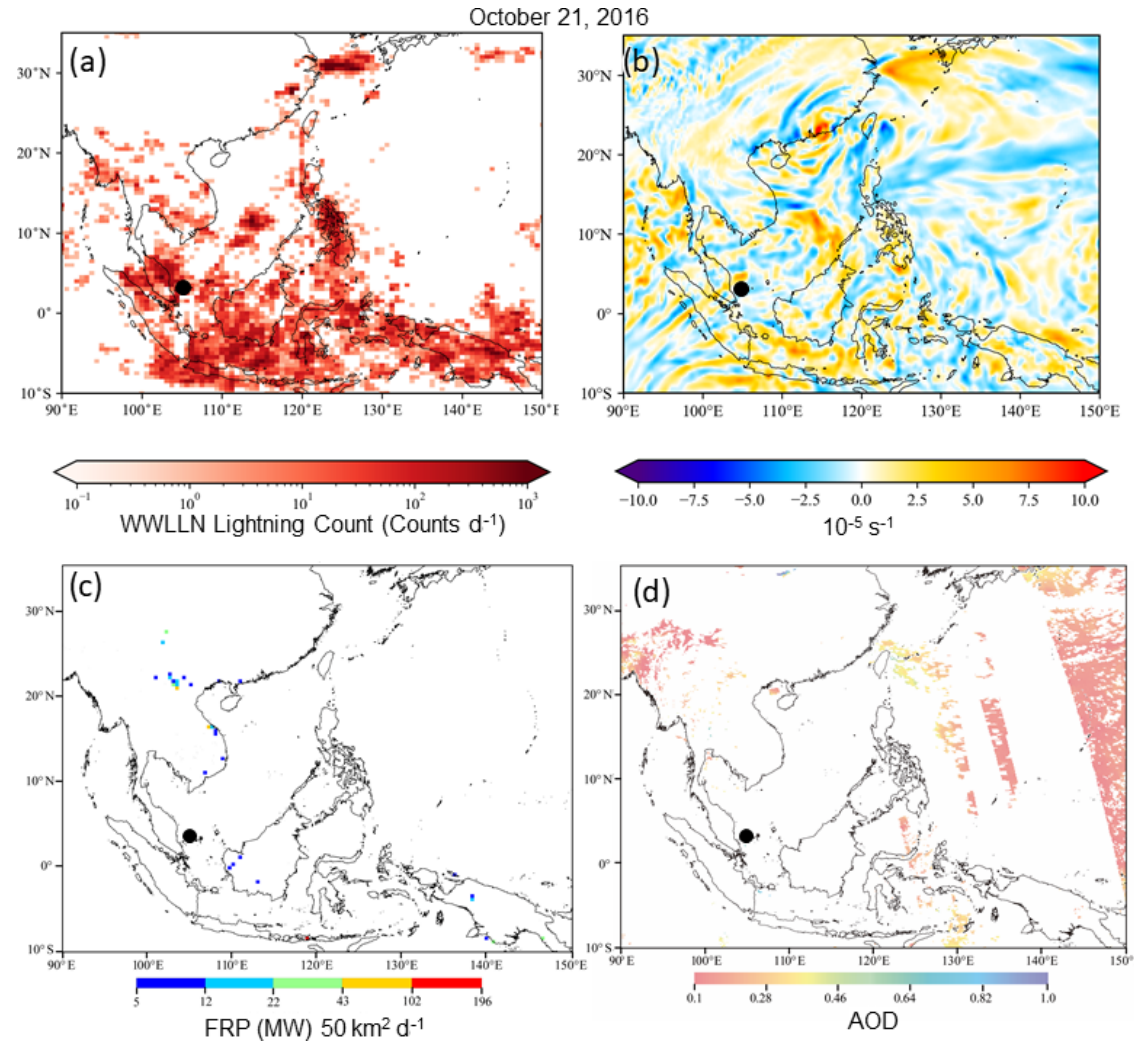
Figure 15. Same as Fig. 13 but for the EIE event recorded on 21 October 2016 (black